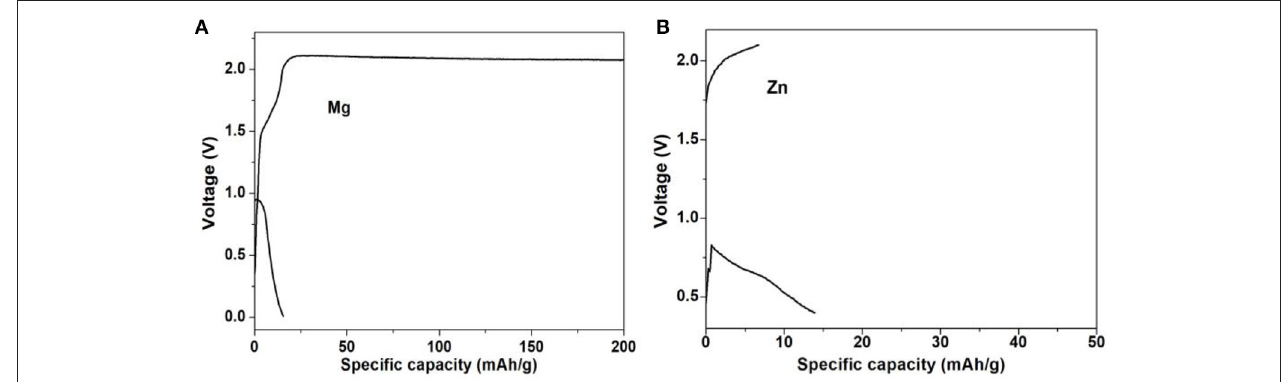
FIGURE 8 | Galvanostatic charge-discharge curves of MoS 2 for (A) Mg and (B) Zn-ions battery.